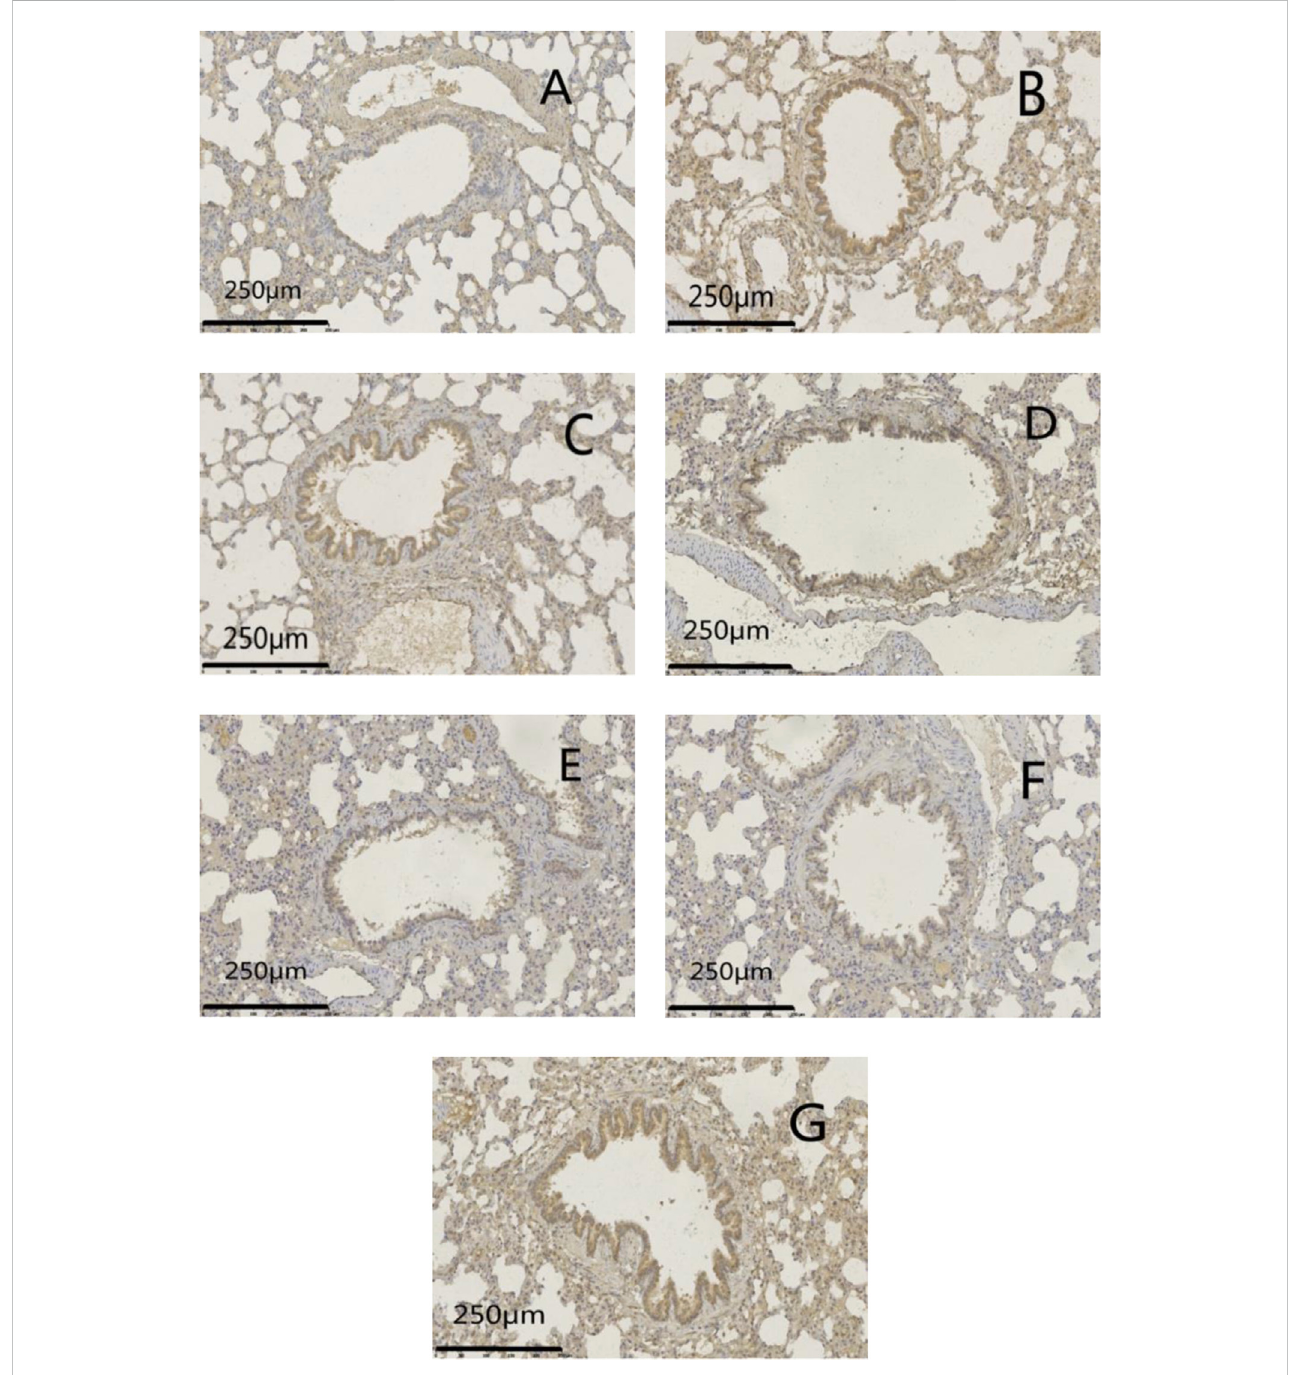
FIGURE 11 Effects of GSZC granules on lung EGFR protein expression in rats suffering from asthma. (A-G) were normal group, model group, GSZC low dosage group, GSZC moderate dosage group, GSZC high dosage group, Dexamethasone acetate group, Yupingfeng granules + Liujunzi pills group, respectively. Scale bars: 250 μ m, magni fi cation: